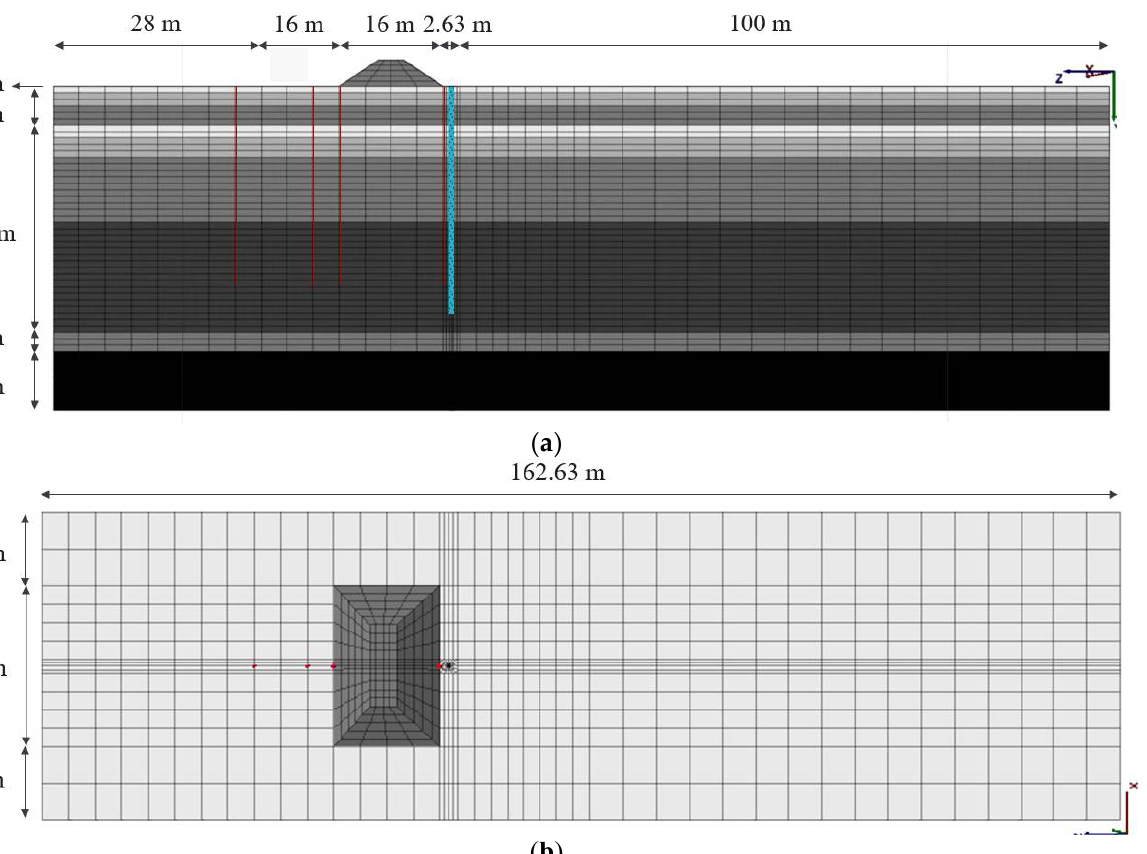
Figure 4. The schematic diagram of the welding joints of the steel pipe pile. 3.2. Soil and Structure Properties The soil, steel pipe pile, and inclinometer tube were simulated using the zone-type, shell-type, and pile-type elements, respectively. The shell-type element can reflect the ac- tual geometric size of the steel pipe pile and be used in the numerical model. The material